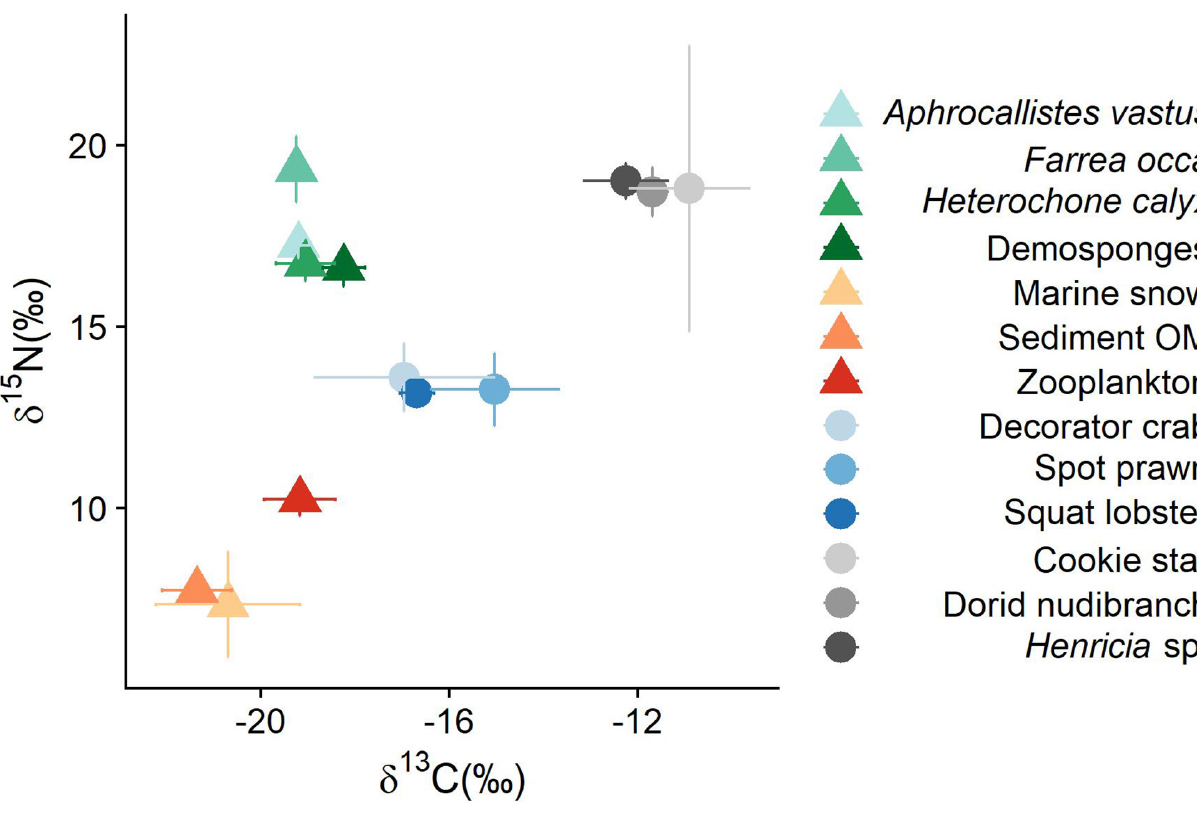
Frontiers in Marine Science |